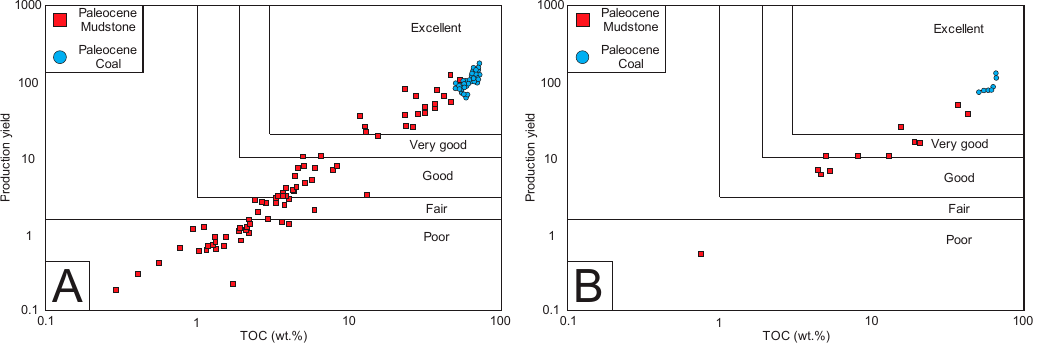
Figure 10. Cross plot of production yield versus TOC to exhibit the generating potential of the Cerrejón Formation in the ( A ) ANH-CARRETALITO-1 and ( B ) ANH-CAÑABOBA-1 wells. The diagram of S2 versus TOC proposed by Langford and Blanc [46] was used to classify the type